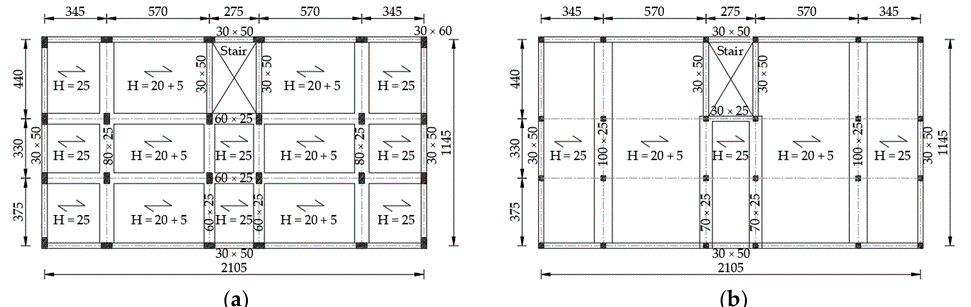
Figure 2. Plan views of existing buildings for the ( a ) L’Aquila and ( b ) Napoli. Table 1. Total mass and axial loads of archetype buildings .